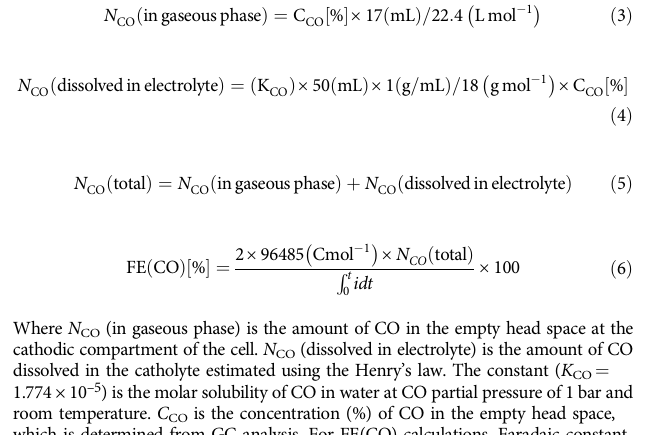
In situ measurements . The lab-made acryl kit was used for the in situ X-ray measurements (Supplementary Fig. 25). The potential range used for the in situ X- ray measurements was determined after con fi rming the potential range suf fi cient for transforming Pd into the PdH phase. In situ XAFS measurements 52,53 were conducted in the 2 – 2 beamline (for Pd K- edge, Ag K-edge, and Pt L 3 -edge) at Stanford Synchrotron Radiation Laboratory (SSRL) and in the 9-BM beamline (for Cu K-edge) at Advanced Photon Source (APS). While transmission mode was used at Pd K-edge, fl uorescent mode was used at the other element ’ s edges, mainly because of the diluted amount of elemental content. The typical duration for a single spectrum was ~17min. During all of the XAFS measurements, the spectrum of each reference metal foil (i.e., Pd, Ag, Pt, and Cu) was simultaneously recorded, and was further used for calibrating the edge energy (E 0 ) of the sample under analysis. More details regarding the experimental procedures and data analyses 54 are provided in the Supplementary Information. In situ XRD measurements were performed in the 17-BM-B beamline at APS. A Perkin-Elmer amorphous silicon detector was used under the transmission mode. The wavelength was 0.24141Å. The duration elapsed for an individual diffraction pattern was controlled to 2min. The obtained 2D ring patterns were integrated and converted to 1D diffraction patterns by using GSAS-II software 55 . The areal mass loading was c.a . 8.5 mgcm − 2 to achieve the suf fi cient diffraction intensity. A laboratory-made H-shaped acryl cell was used for electrochemical operations. During the measurements, CO 2 gas was continuously bubbled into the electrolyte. The other conditions were the same as in the electrochemical measurements. The potential was scanned at a scan rate of 0.05mV s − 1 under LSV mode in a range from 0.2 to − 0.7 V RHE . So, the potential interval for each XRD pattern was 6mV. Every fourth XRD pattern ( = 24mV) was chosen in Fig. 3. Faradaic ef fi ciency and partial current density calculations . The Faradaic ef fi - ciency (FE) for CO (FE(CO)) was calculated by using the following Eqs. (3 – 6) 2,17 :